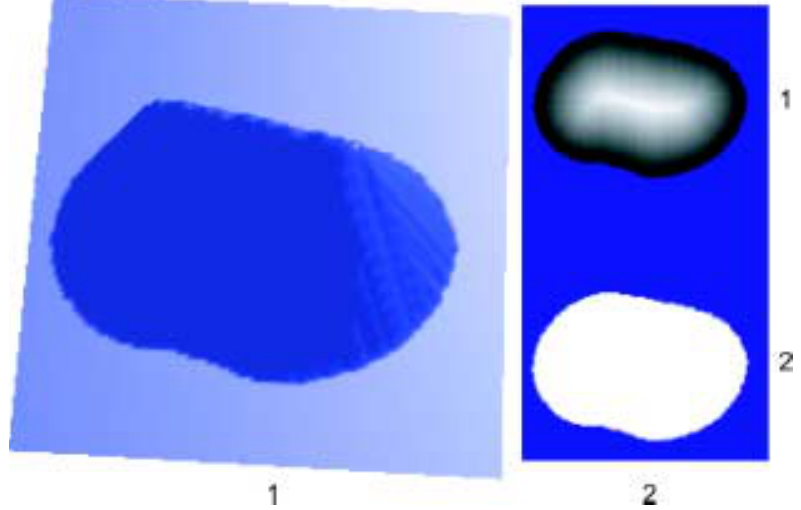
Fig. 8. Mask of the cell, the object (2 2) and the distance transformation as intensity image (2 1) and as pseudo spatial representation (1 1). This figure can be viewed on http://www.esacp.org/acp/2003/25-1/rodenacker.htm. is an approximation of | ( ∂I ( x , y ) /∂x , ∂I ( x , y ) /∂y ) | . The G . . . features can be considered as a